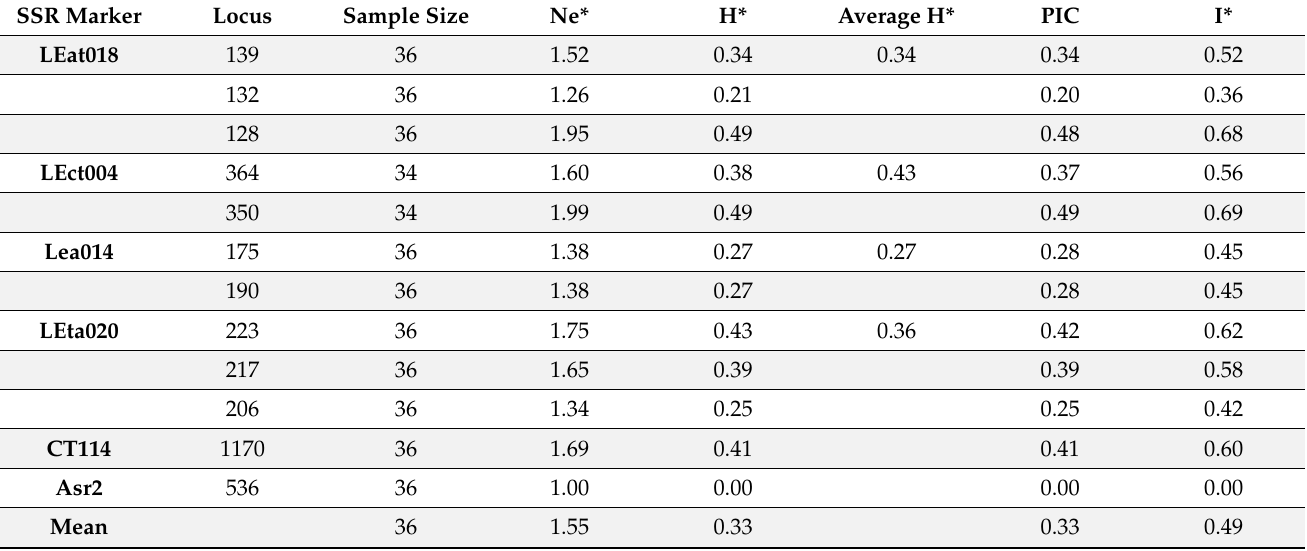
Table 3. SSR names, the total number of bands/primers, loci, monomorphic, polymorphic loci, and percentage of